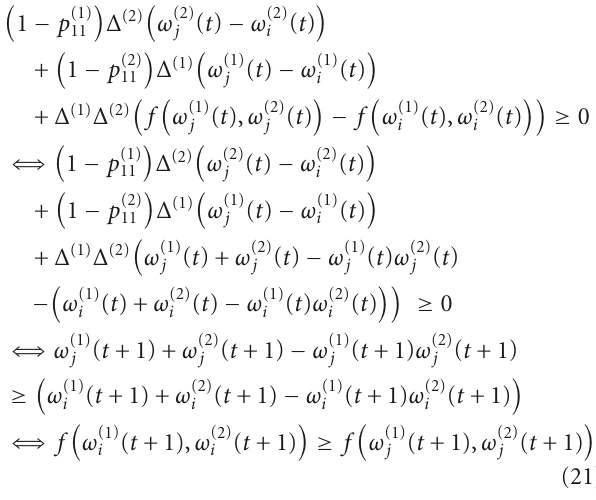
have the smallest probability of being in state 1 at each